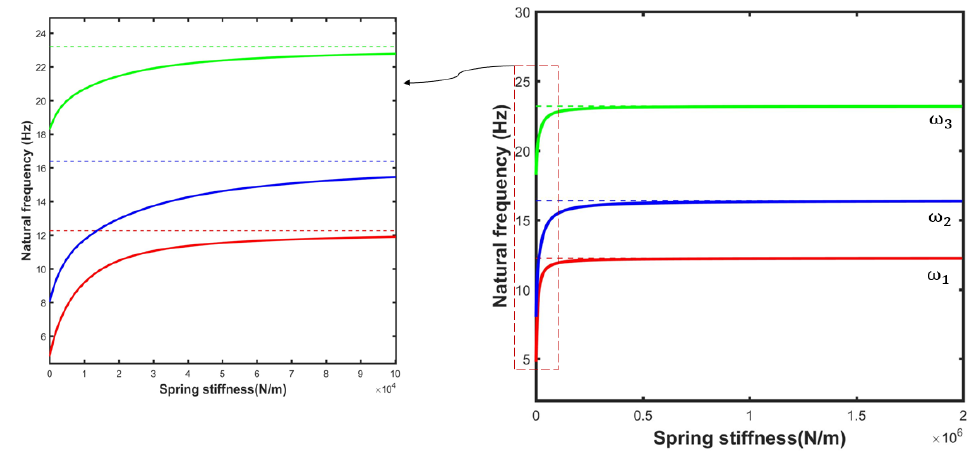
Figure 13. Influence of spring stiffness variation on the first three fundamental natural frequencies of the plate shown in Figure